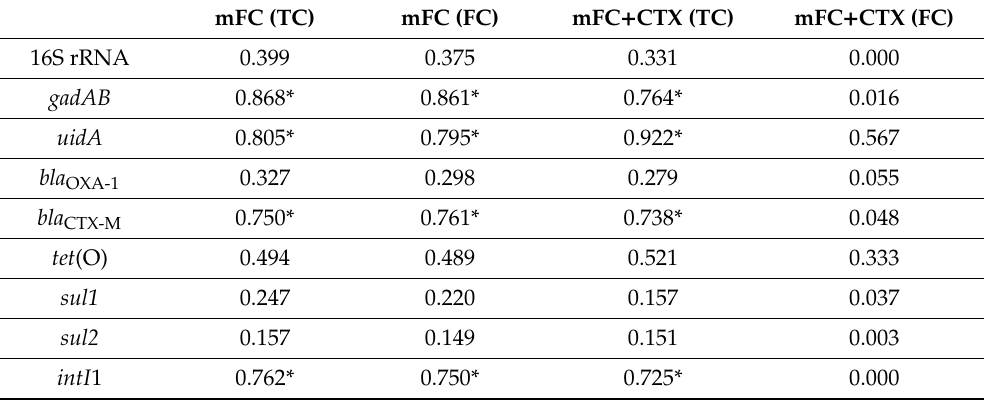
Table 1. Linear regression coe ffi cients comparing target genes and colony forming units on mFC medium with and without cefotaxime (CTX, 4 mg / L). n = 13 for these analyses, including wastewater treatment plant influent (n = 3), wastewater collected after secondary wastewater treatment (n = 3), and wastewater collected after UV disinfection wastewater treatment (n = 3) samples collected in US and wastewater treatment plant influent (n = 2) and wastewater collected after secondary wastewater treatment (n = 2) samples collected in PT. TC—presumptive total coliforms and, FC—presumptive fecal